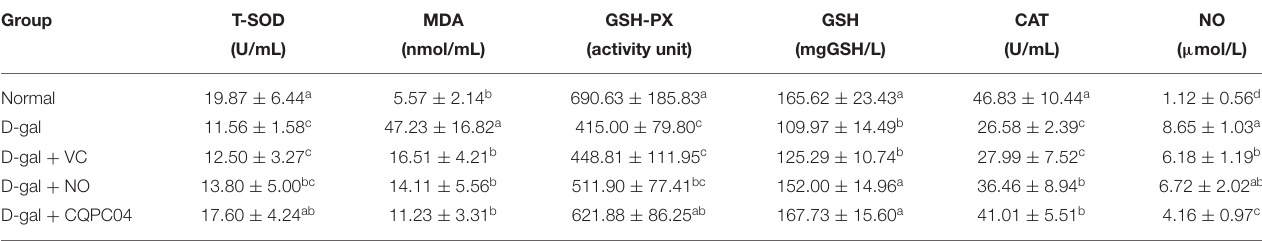
TABLE 2 | Levels of oxidative aging indicators in serum of D-gal induced aging mice. Group T-SOD